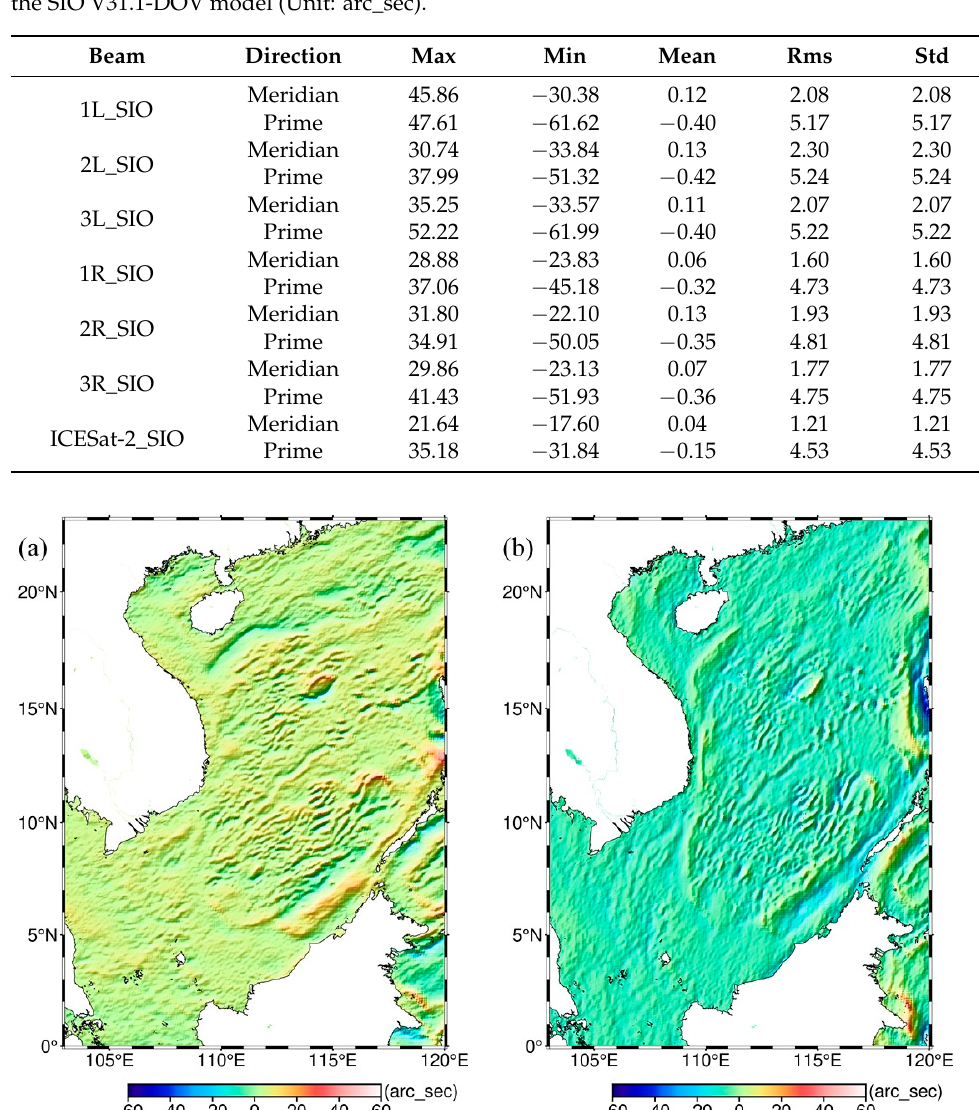
Figure 7. ( a ) The meridian component of the gridded DOV calculated by the ICESat-2 along-beam DOV; ( b ) the prime vertical component of the gridded DOV calculated by the ICESat-2 along-beam DOV. Table 10. Statistics of differences between gridded DOVs calculated by the along-beam DOVs and the XGM2019e_2159-DOV model (Unit: arc_sec).